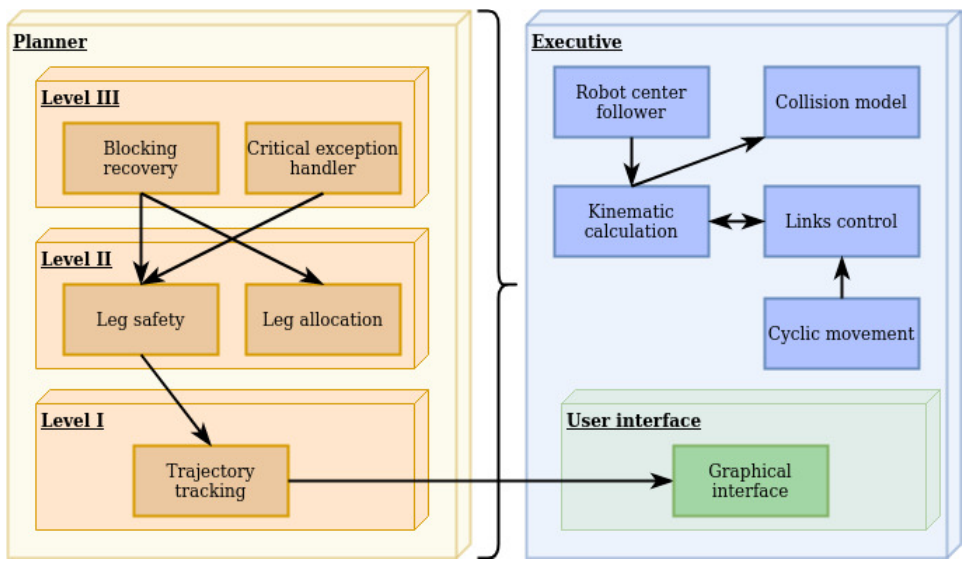
Figure 4. Control